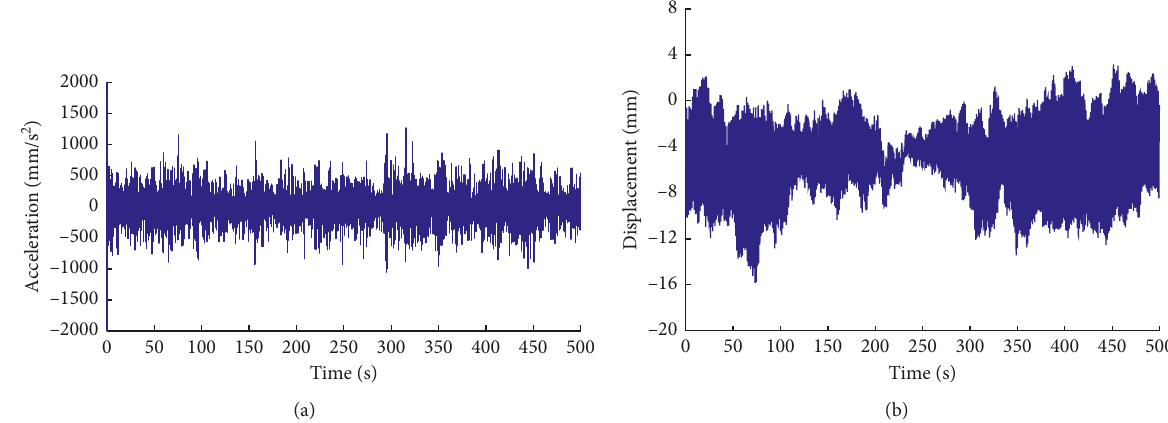
Figure 2: Time-history curves of acceleration and displacement at 25m: (a) acceleration at 25m; (b) displacement at 25 m.